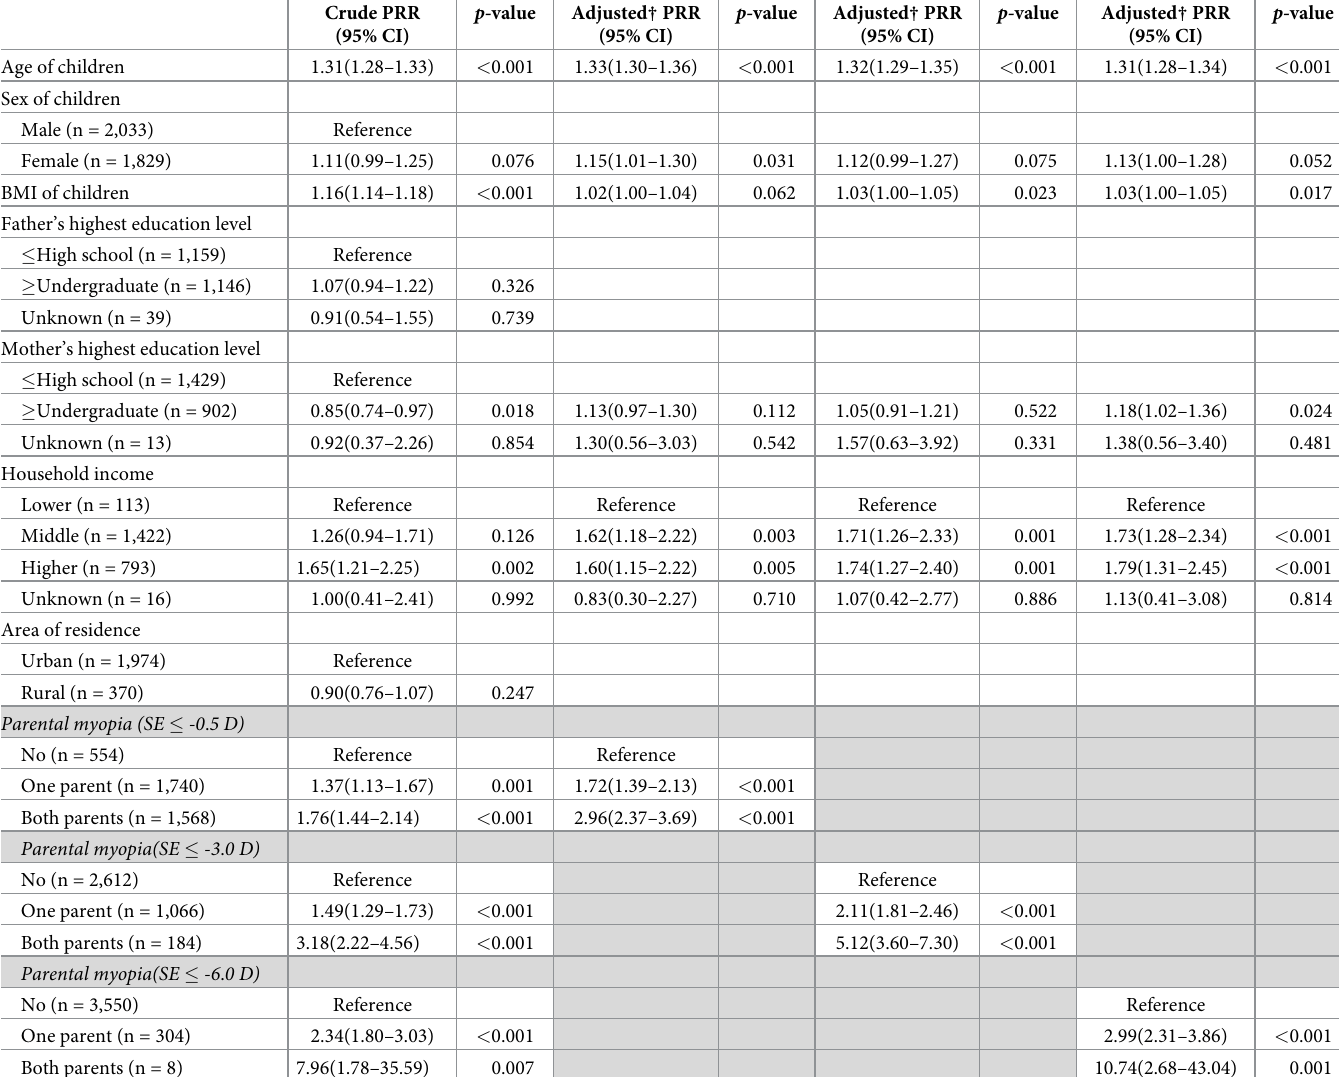
Table 4. Risk factors for pediatric myopia categorized as none = SE > -0.5 D, mild = -3.0 < SE � -0.5 D, moderate = -6.0 < SE � -3.0 D, and high myopia = SE � -6.0 D, according to the different levels of parental myopia, which is mild (SE � -0.5 D), moderate (SE � -3.0 D) and severe (SE � -6.0